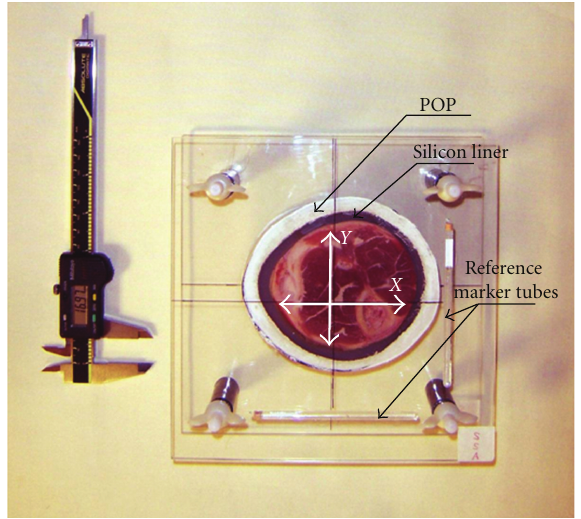
Figure 1: Animal specimen within Perspex fixator rig wrapped with silicon liner and POP. The X and Y cross-sectional diameters were defined at the midpoint of the reference marker tubes.